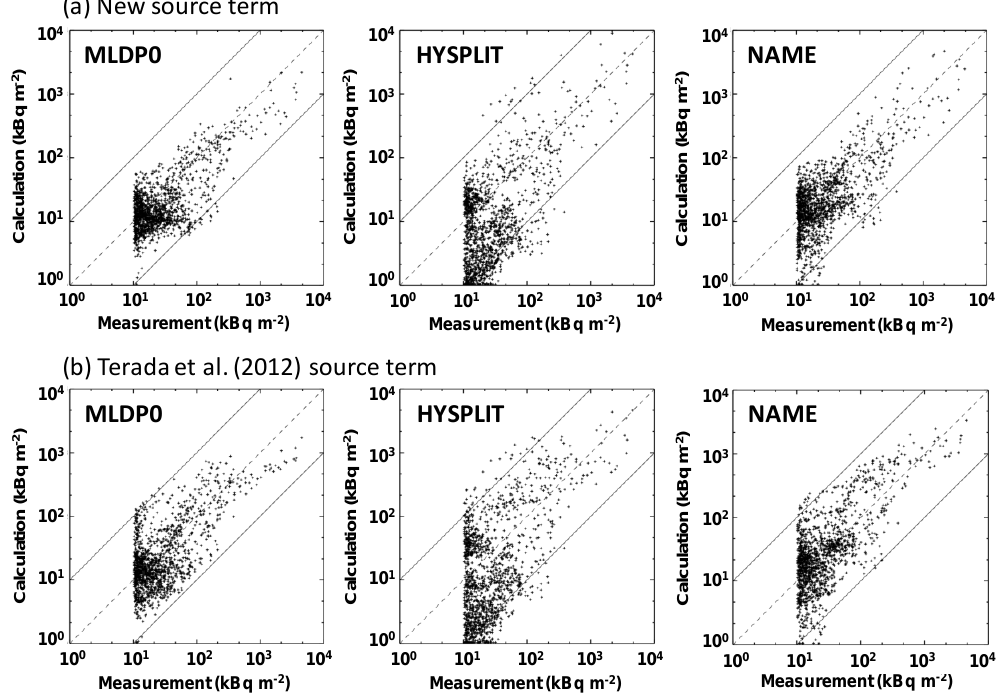
Figure 19. Scatter diagrams of surface deposition (kBqm − 2 ) comparing measurements and calculations using three WMO models (MLDP0, HYSPLIT, and NAME) with the source term of (a) this study and (b) Terada et al. (2012) on 1 April 2011. The black dashed lines show the 1:1